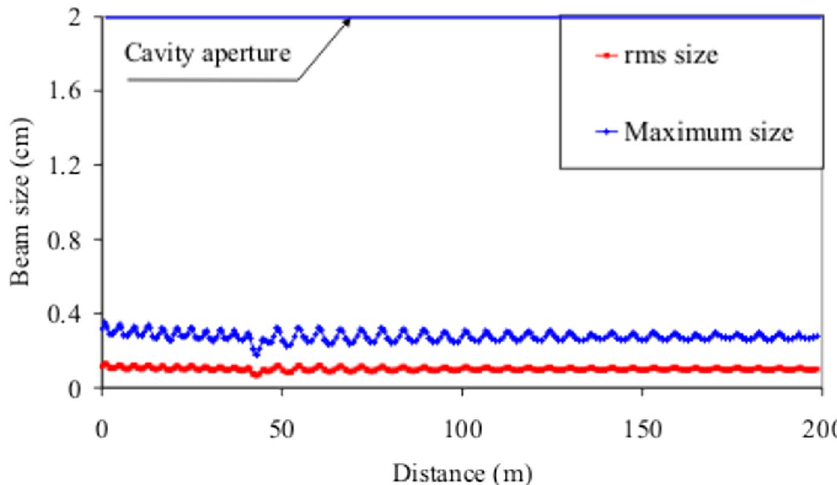
size.FIG. 5. (Color) Beam in the transverse horizontal plane through the high- (cid:3) section of the triple-spoke cavity based linac. The upper limit of the scale is the cavity aperture, the lower curve is the rms size, and the upper curve the maximum